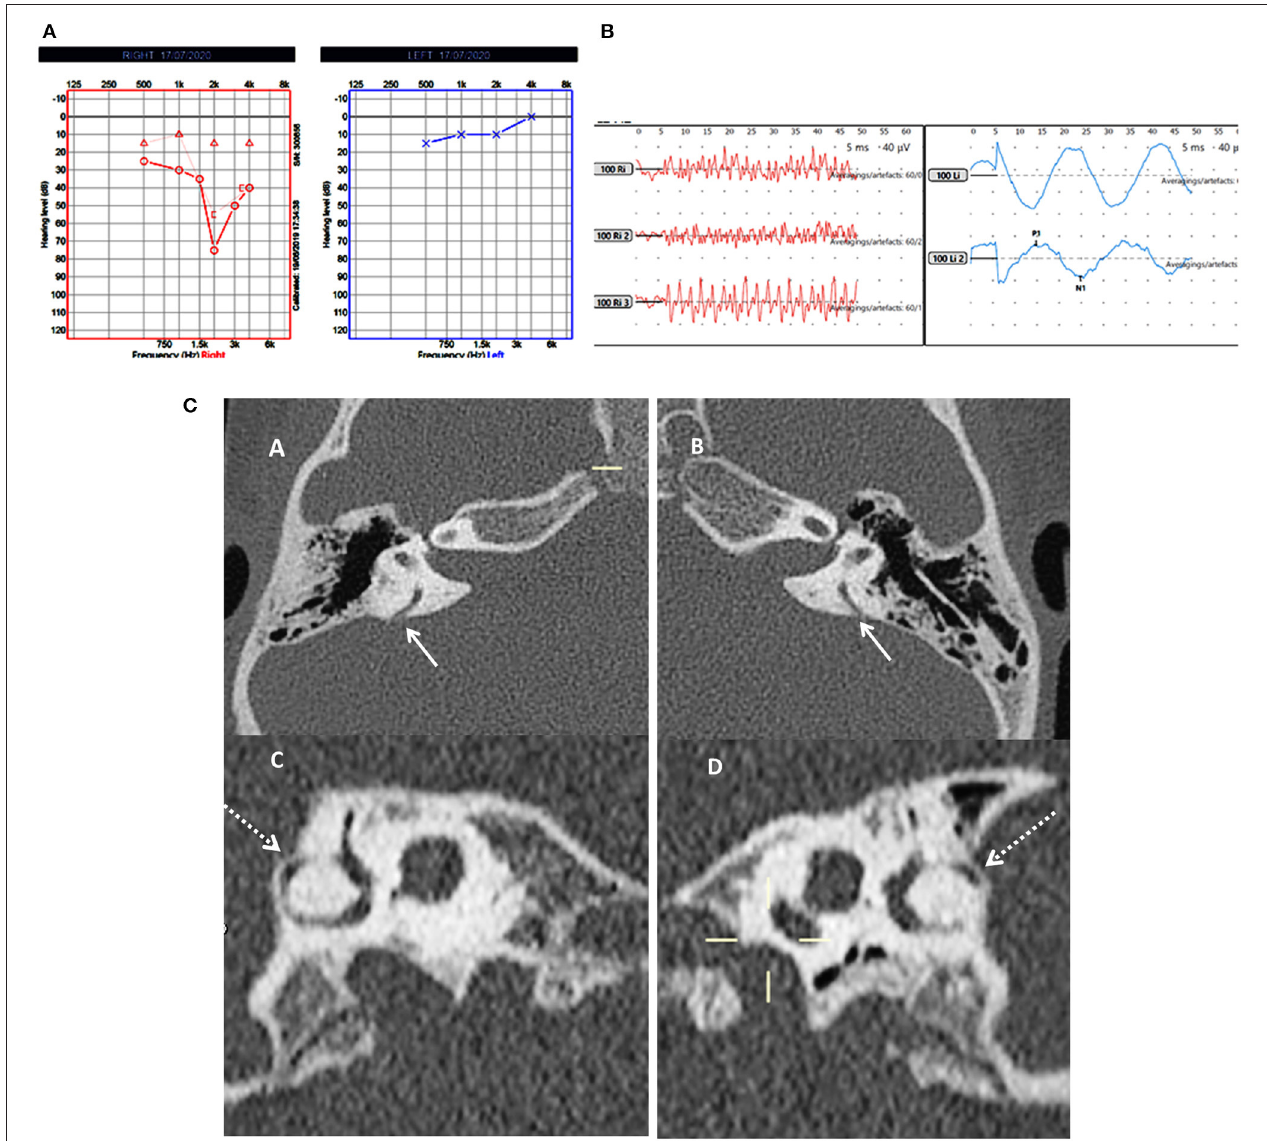
FIGURE 2 | Case number 5—Bilateral posterior semicircular canal thinning. (A) , Pure tone audiometry showing right mixed hearing loss. (B) , cVEMP showing absent response on the right and normal amplitude on the left; in this child vHIT was normal and there were no symptoms of balance problems. (C) —CT scan images of the right (A) and left (B) petrous temporal bone in the axial plane demonstrates apparent dehiscence of the posterior semi-circular canal (white arrows). Sagittal oblique reconstruction of the right (C) and left (D) petrous temporal bone parallel to the plane of the posterior semi-circular canal demonstrates thinning of the overlying bone (dotted arrows) measuring 0.5mm in thickness on both